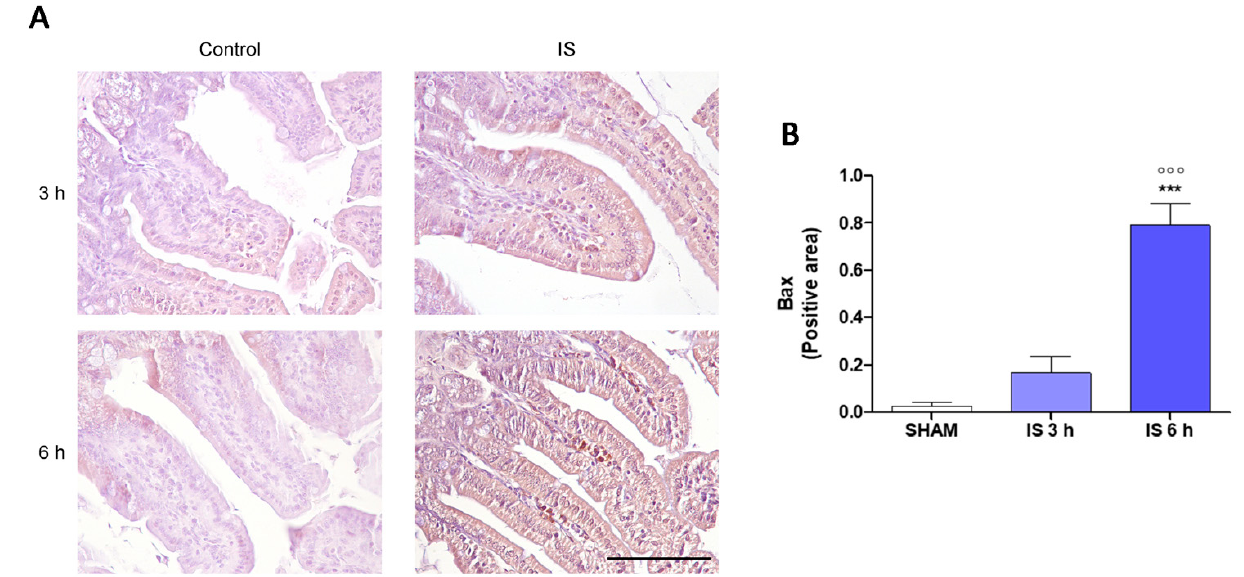
Figure 3. Immunohistochemical localization of Bax ( A , B ) of Indoxyl Sulfate (IS; 800 mg/kg; i.p.)-treated mice, after 3 h and 6 h of treatment (40× magnification, Scale Bar = 100 µm). *** denote p < 0.001 vs SHAM; °°° denote p < 0.001 vs IS 3 h.